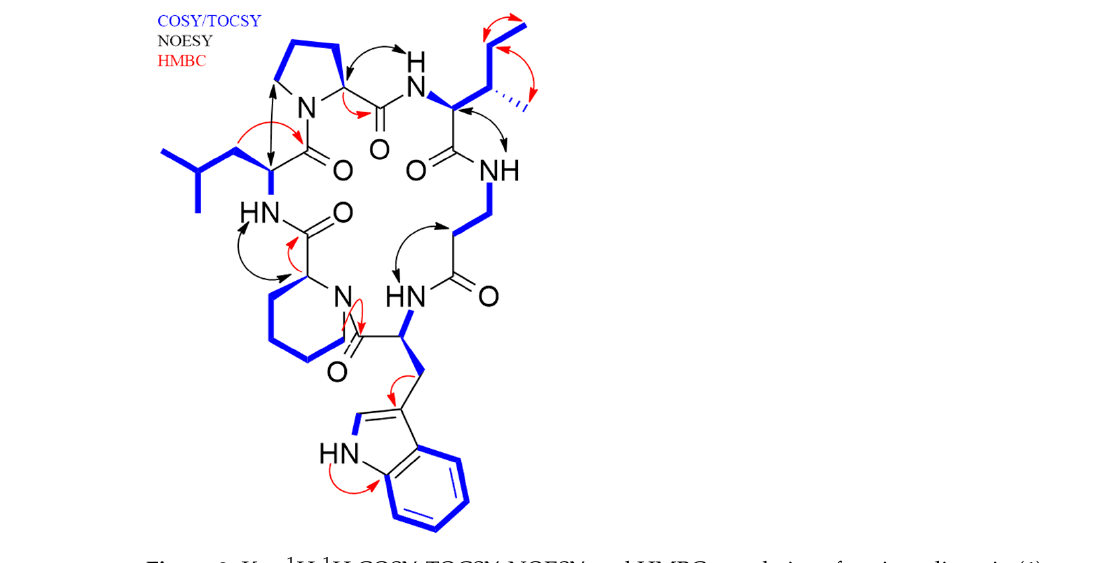
Figure 2. Key 1 H ‐ 1 H COSY, TOCSY, NOESY, and HMBC correlations for pipecolisporin ( 1 ). Figure 2. Key 1 H- 1 H COSY, TOCSY, NOESY, and HMBC correlations for pipecolisporin ( 1 ).